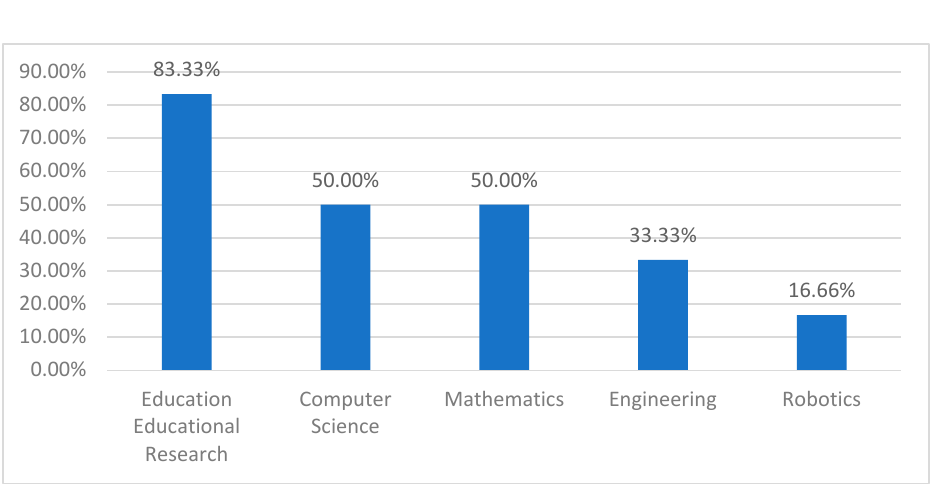
Figure 4. Articles published in the last 10 years in WOS on learning mathematics through ICT resources in primary education. Source: own production.